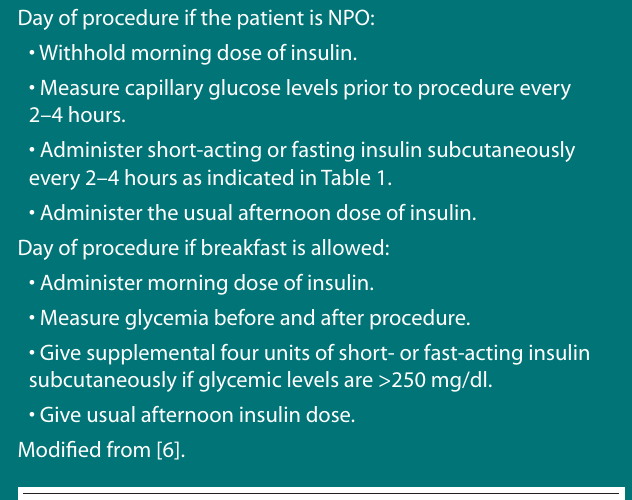
Table 1. Administering Insulin during Minor